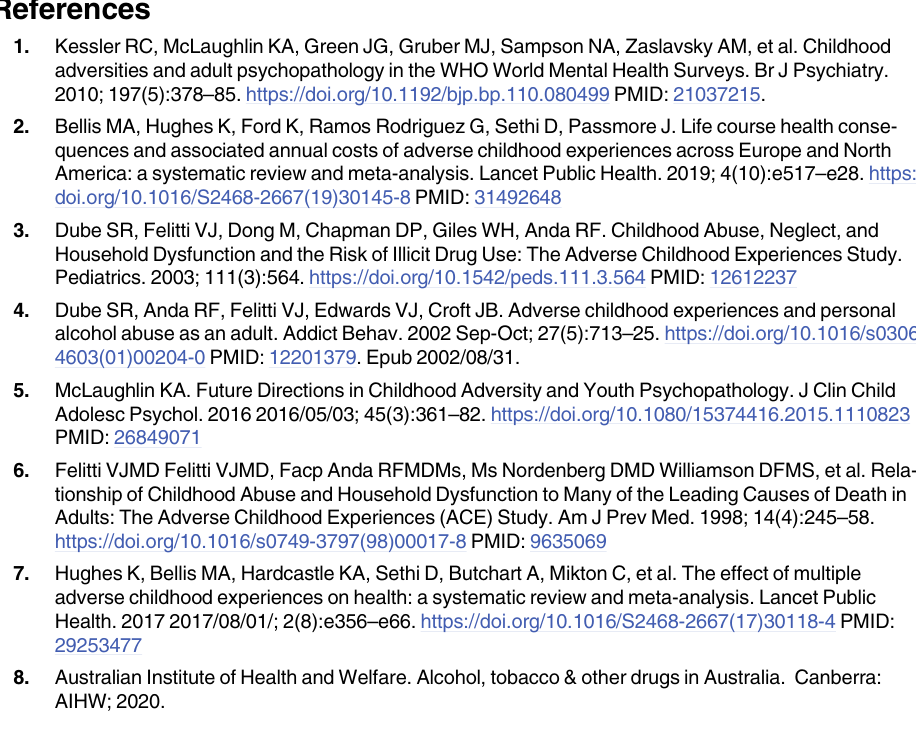
S4 Table. Risk of bias within students, using the Joanna Briggs Institute Critical Appraisal Checklist for Studies Reporting Prevalence Data. S5 Table. The GRADE (Grading of Recommendations, Assessment, Development and Evaluations) approach to assess the strength of the cumulative